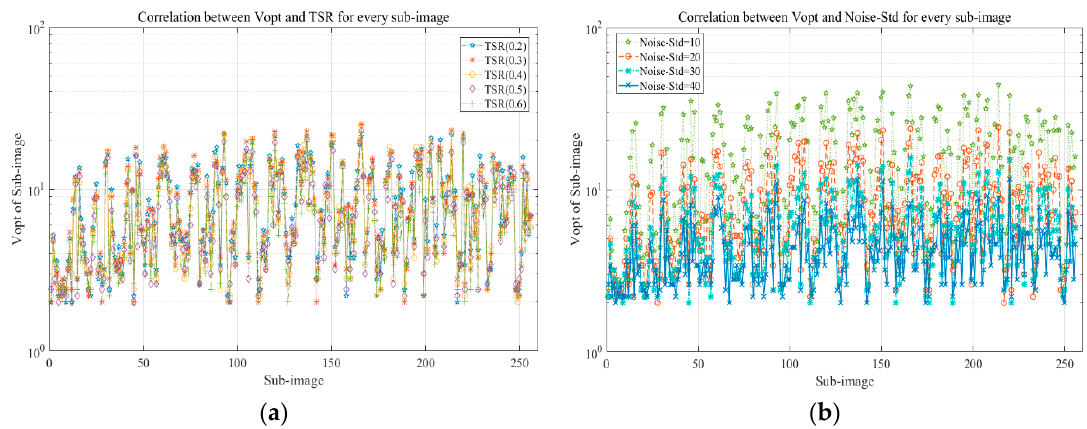
Figure 9. Correlation between v opt , TSR, and Noise-std of sub-images: ( a ) Noise-std = 20, ( b ) TSR = 0.4.